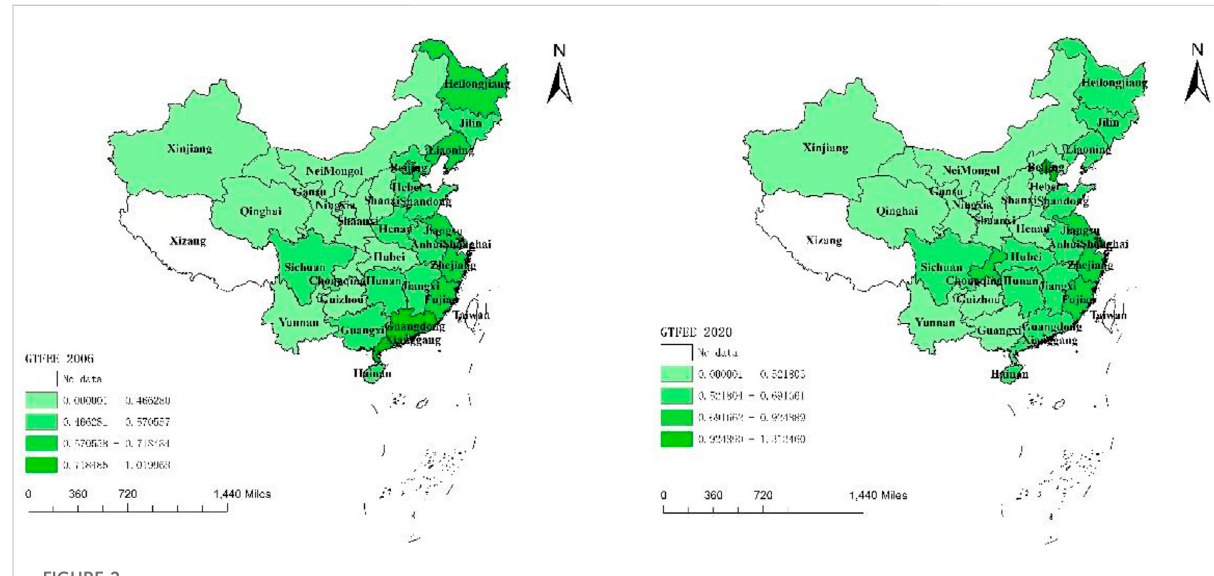
FIGURE 2 The distribution map of GTFEE in 2006 and